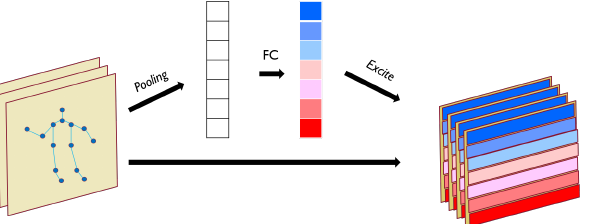
Figure 2. The Joint Attention Module first pools the spatial-temporal feature map, and then uses the linear layer and Softmax to obtain the attention weight, which is used to perform element multiplication with the original feature map. Finally, each joint receives different attention in the feature